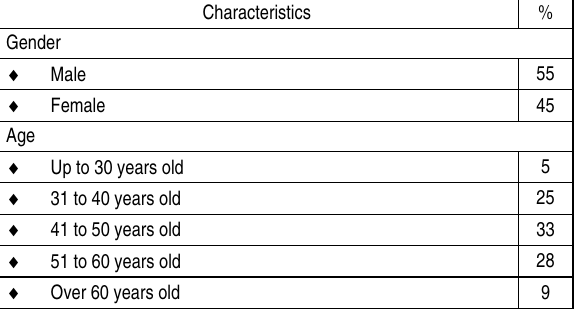
Table 1. Characteristics of the respondents